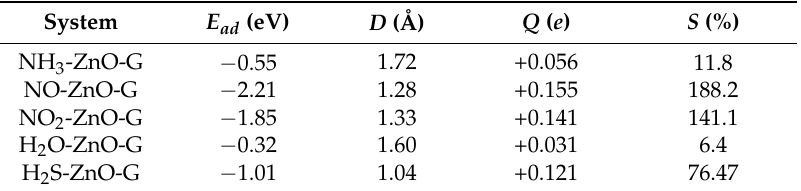
Table 1. The calculated adsorption energy ( E ad ), binding distance ( D ) which is the shortest atom to atom distance between the molecule and the sensor, the charge transfer ( Q ), and the evaluated value of the sensitivity of the sensor with respect to each gas molecule ( S ). The positive value of charge indicates a charge transfer from the molecule to the